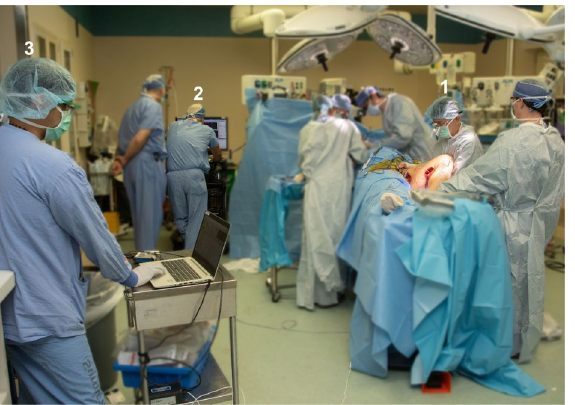
Figure 1. Layout of operating room for intraoperative muscle force measurement. (1) The surgeon and assistant hold the leg in position while the surgeon keeps the stimulator probe on the obturator nerve during stimulation. (2) Neurophysiologist determines the settings for maximum compound muscle action potential (CMAP) then performs the 2 Hz and 20 Hz stimulation at 50% and 25% of the current required to produce maximal CMAP. (3) Research scientist records the output from the BFT using a custom LabVIEW interface. The neurophysiologist coordinates with the research scientist to indicate the start of each stimulation